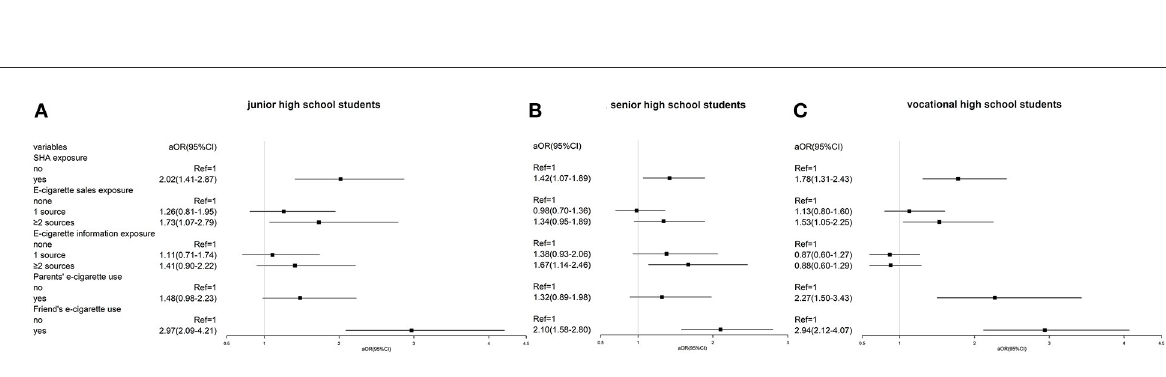
FIGURE2 (A–C) Stratification of association between social-environmental exposure and e-cigarette use by school